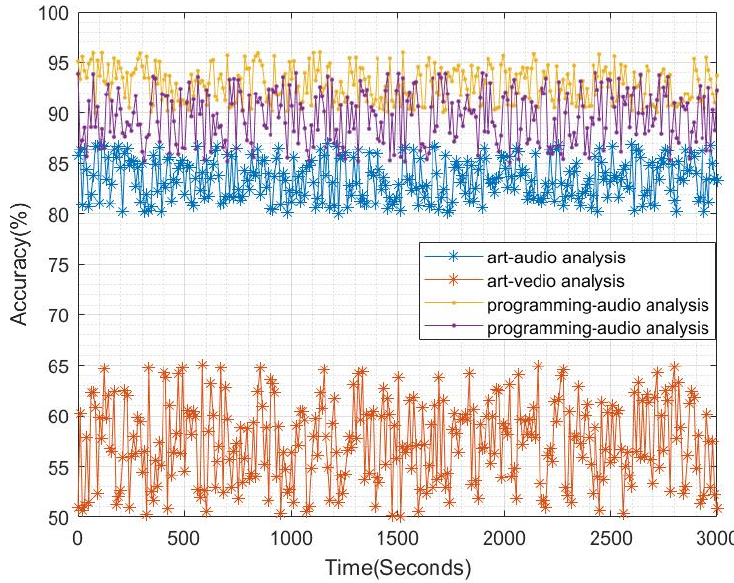
Figure 10. The accuracy for audio and video analysis between the art and programming courses.